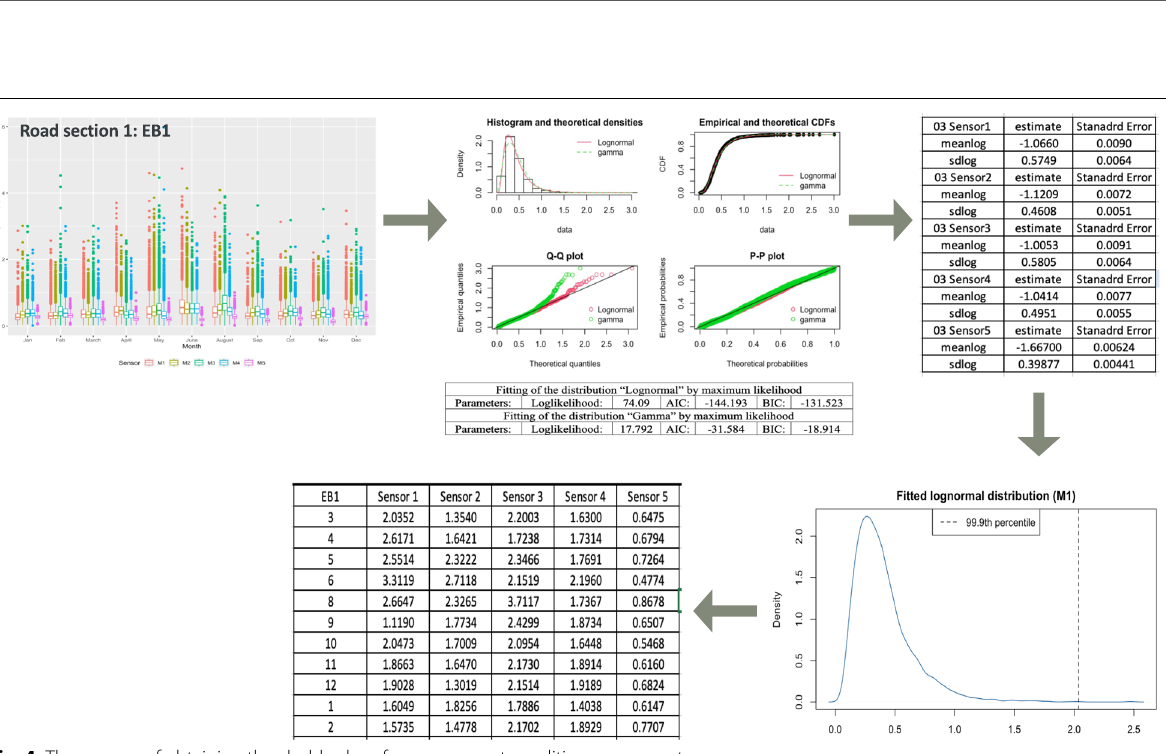
Fig. 3 Density plots of magnitude values in log scale from two road sections. a Density plots of magnitude values in log scale from eastbound lane 1. b Density plots of magnitude values in log scale from eastbound lane 2. c Density plots of magnitude values in log scale from northbound lane 1. d Density plots of magnitude values in log scale from northbound lane 2